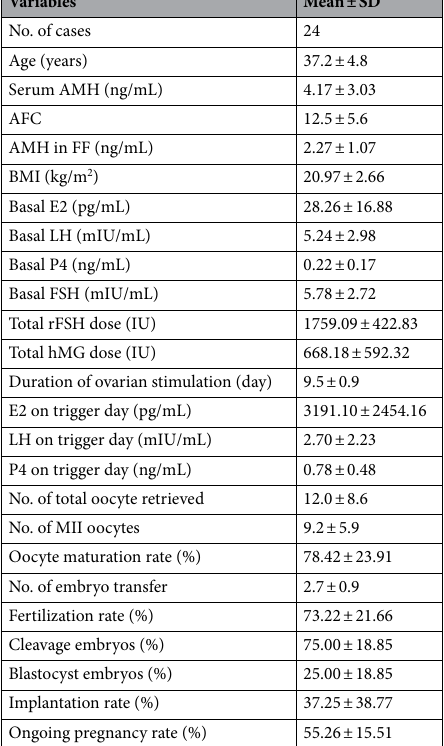
Ovarian stimulation protocol. Ovarian stimulation was induced in all participants using the GnRH antagonist protocol. A controlled ovarian stimulation (COS) protocol with human recombinant FSH (Gonal-F, Merck Serono) and highly purified hMG-HP (Menopur, Ferring) was initiated on menstrual cycle days 2 or 3 at